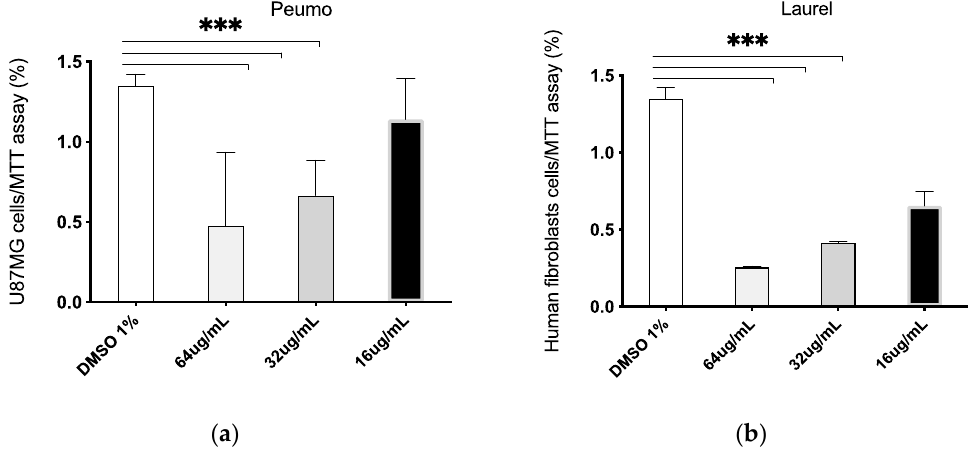
Figure 4. Dose-response curve of human glioblastoma cells tumor cell line U87MG treated with Cryptocarya alba (Peumo; CA); Laurelia sempervirens (Laurel; LS) EOs. The graph bar corresponds to the proliferation of U87GMtreated with the Eos (a. Peumo) and (b. Laurel), at different concentrations versus control (DMSO 1%) for 48 h, evaluated by MTT assay at 570 nm. Three independent trials were performed, in triplicate, for each treatment and concentration. *** p < 0.001.